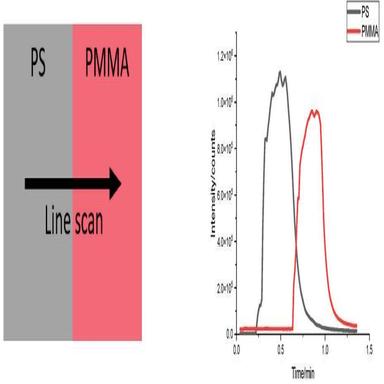
Schematic setup of the PS-PMMA sample (left) and summed intensity for characteristic fragments for PS and PMMA showing the lateral resolution of a sample with a boundary between the two polymers (right).